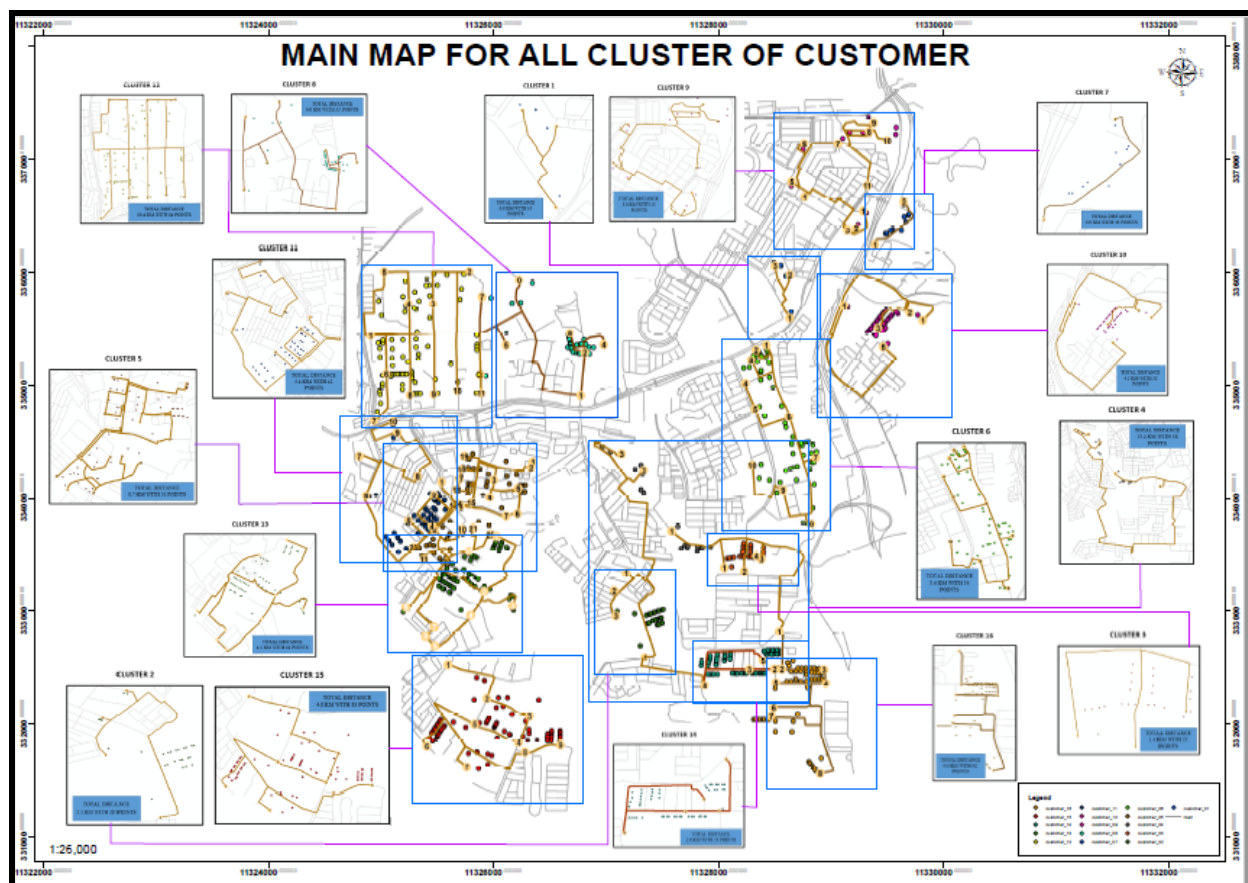
Figure11 Main map for all